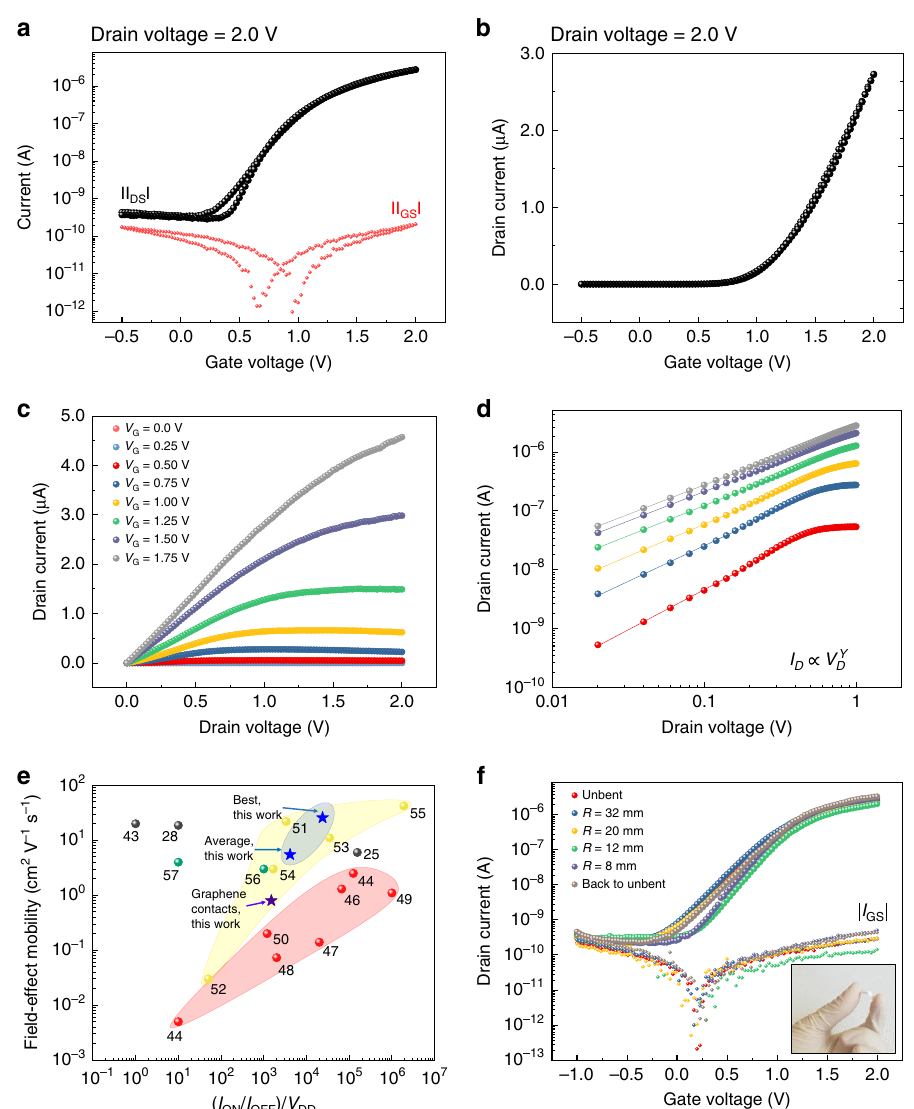
Fig. 2 Electrical characterization of the MoS 2 FETs with inkjet-printed silver contacts in ambient conditions. a Typical transfer characteristic curve measured as a function of the gate voltage for a drain voltage of 2.0 V. Logarithmic scale: black dots, drain current; red dots, gate current. b Typical transfer characteristic curve measured as a function of the gate voltage for a drain voltage of 2.0 V in linear scale. c Typical output characteristic measured at different gate voltages (from V GS = 0.0 V to V GS = 1.75 V, steps of 0.25 V). d Log – log curves of the output characteristic in low drain voltage region. Ohmic behavior is observed, suggesting good electrical contact between the silver contacts and MoS 2 . e Field-effect mobility and ( I ON / I OFF )/ V DD for FETs characterized on paper substrates previously reported in the literature. V DD is the supply voltage for each device. Blue stars, this work, inkjet-printed silver contacts; purple star, this work, inkjet-printed graphene contacts; black dots, 2D materials (25, 28, 43); red dots, organic semiconductors (44, 45, 46, 47, 48, 49, 50); yellow dots, inorganic oxides (51, 52, 53, 54, 55); green dots, CNTs (56, 57). f Transfer characteristics and gate leakage currents measured for different bending radii along the current direction for a drain voltage of 2 V; inset, picture of a sample with MoS 2 FET fabricated on